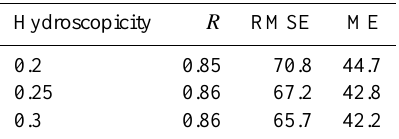
Table 2. Parameters describing the performance of the microphys- ical parametrization in capturing the number of observed cloud droplets, when run for three different hydroscopicity